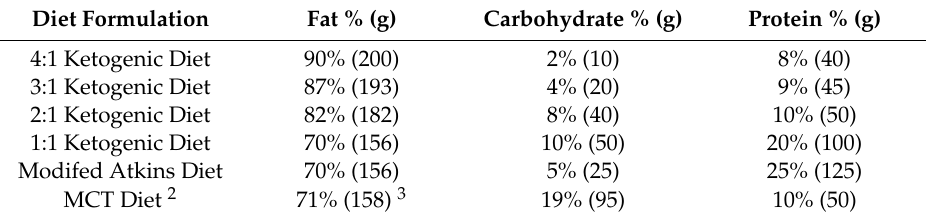
Table 1. Macronutrient composition of common ketogenic diet (KD) formulations 1.